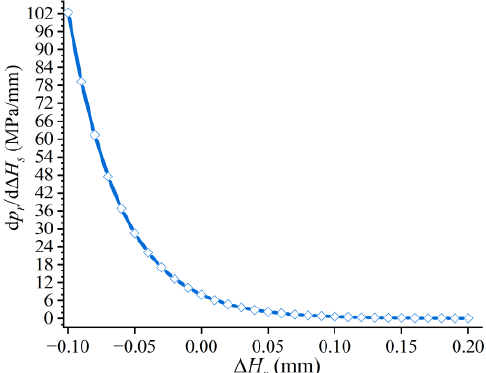
Figure 26. Balance pressure robustness against the deflector installation error.